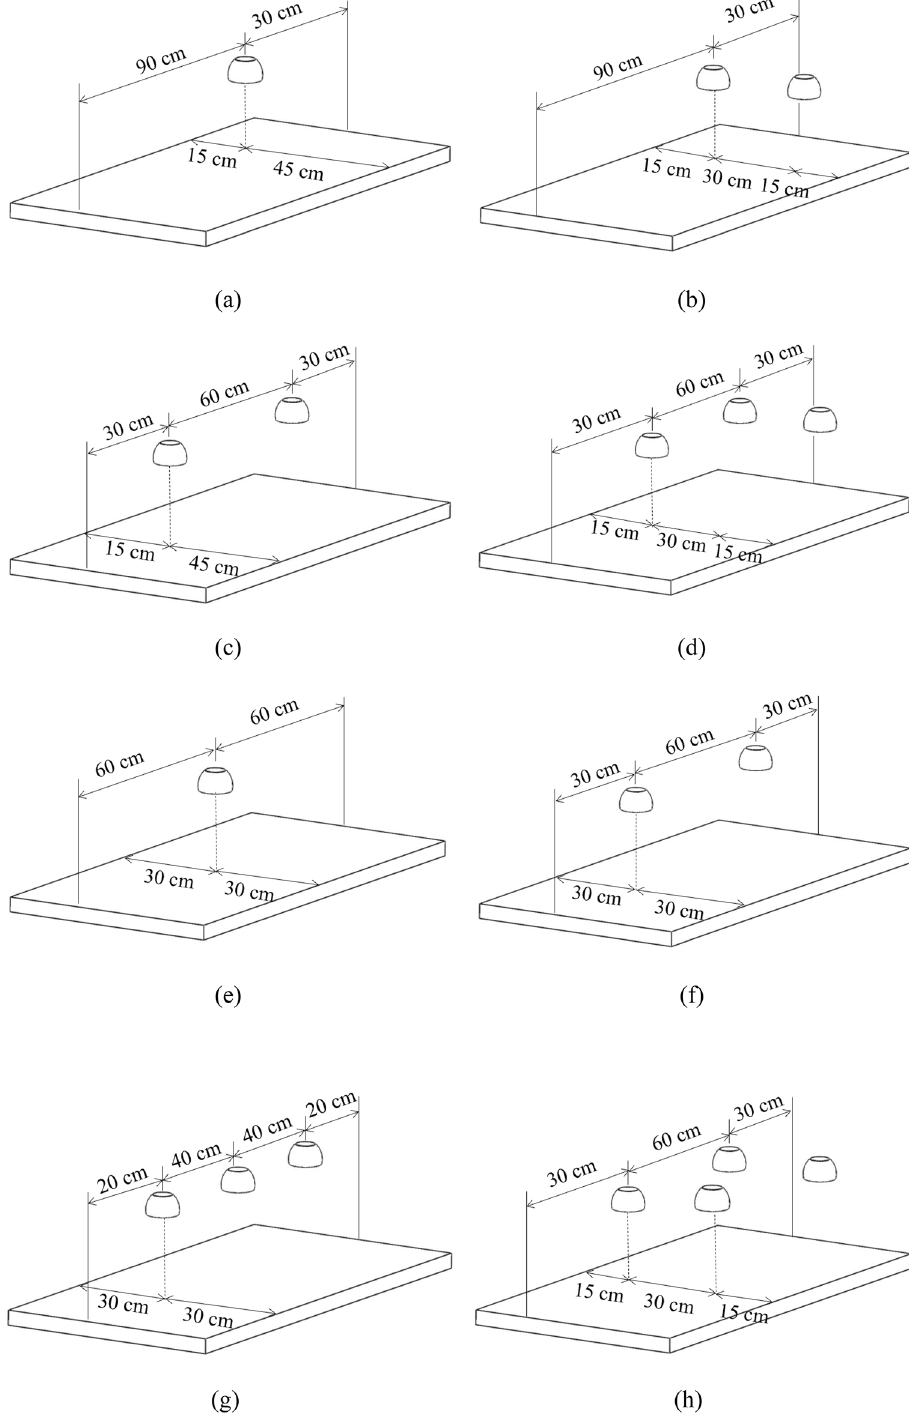
Figure 5. Required numbers and possible positions of far-UVC lamps for typical dining situations: ( a ) one lamp for a single diner; ( b ) two lamps for two diners sitting face to face; ( c ) two lamps for two diners sitting on the same side; ( d ) three lamps for three diners; ( e ) one lamp for four diners; ( f ) two lamps for four diners; ( g ) three lamps for four diners; and ( h ) four lamps for four